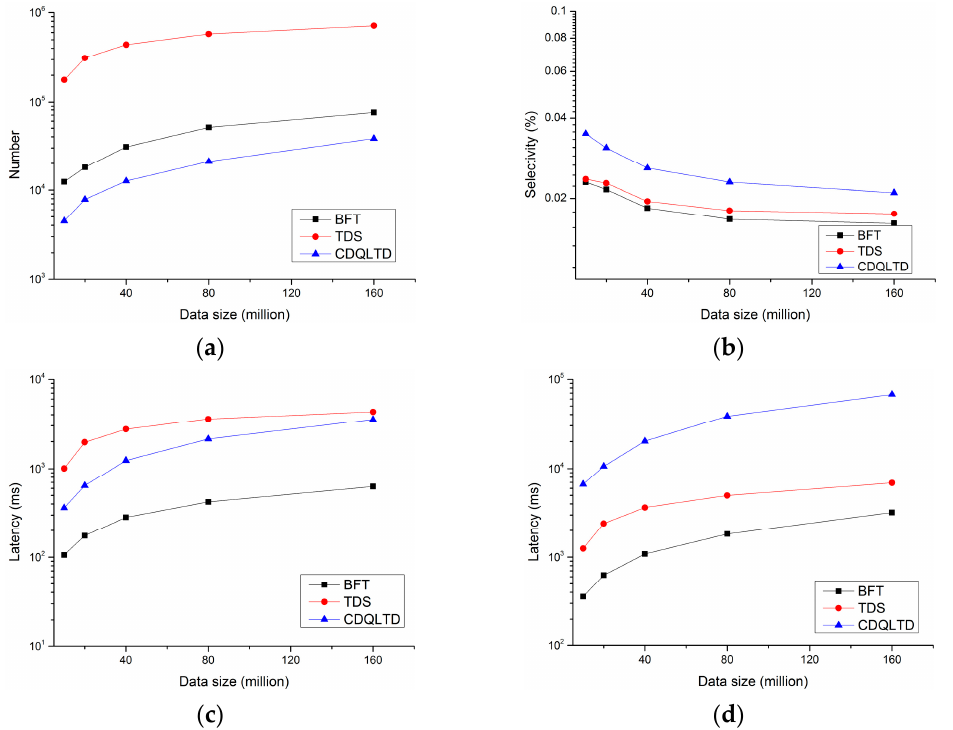
Figure 8. Performance of different scales: ( a ) Number of the accessed nodes, ( b ) selectivity, ( c ) pruning latency, ( d ) query latency.